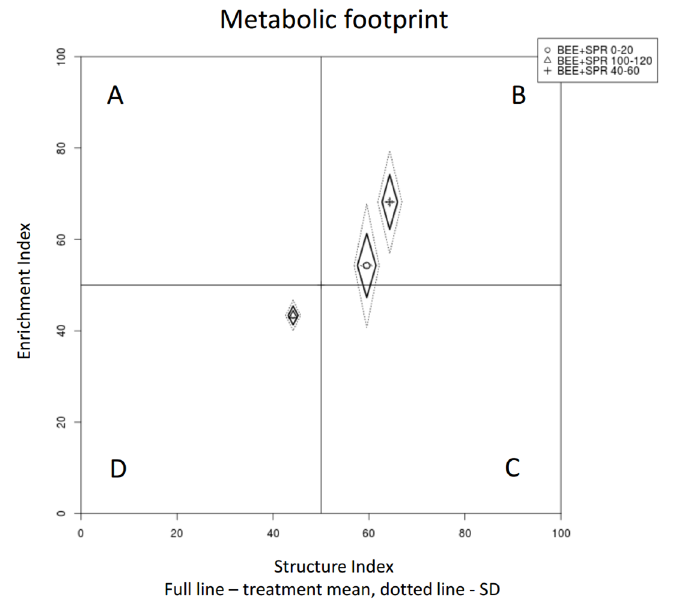
Figure 2. Functional metabolic footprint of nematodes at three different age classes: 0–20-, 40–60-, and 100–120-year-old forests, in 2019 in Pol’ana Mts.